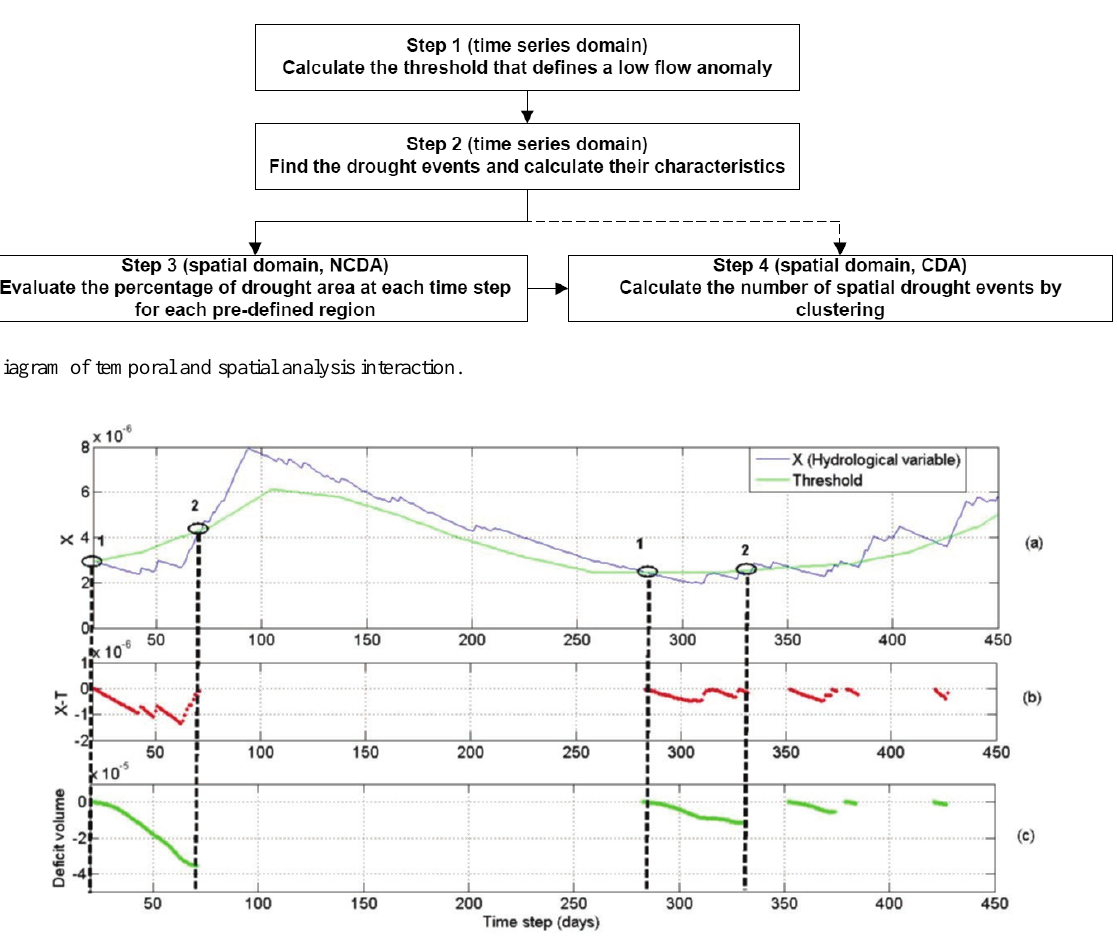
Fig. 3. Drought characteristics calculated with variable threshold: (a) Hydrological variable and variable threshold, (b) daily intensity, (c) event deficit volume. Start and end of the events are named as 1 and